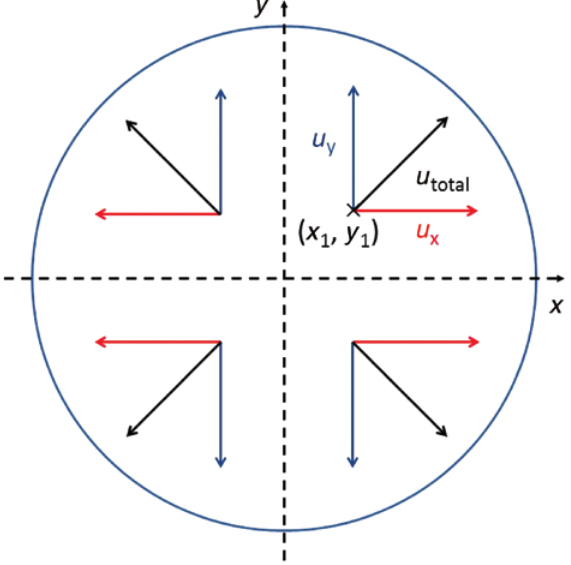
Figure 1: Parity of the displacement along x and y for the dilatational modes.